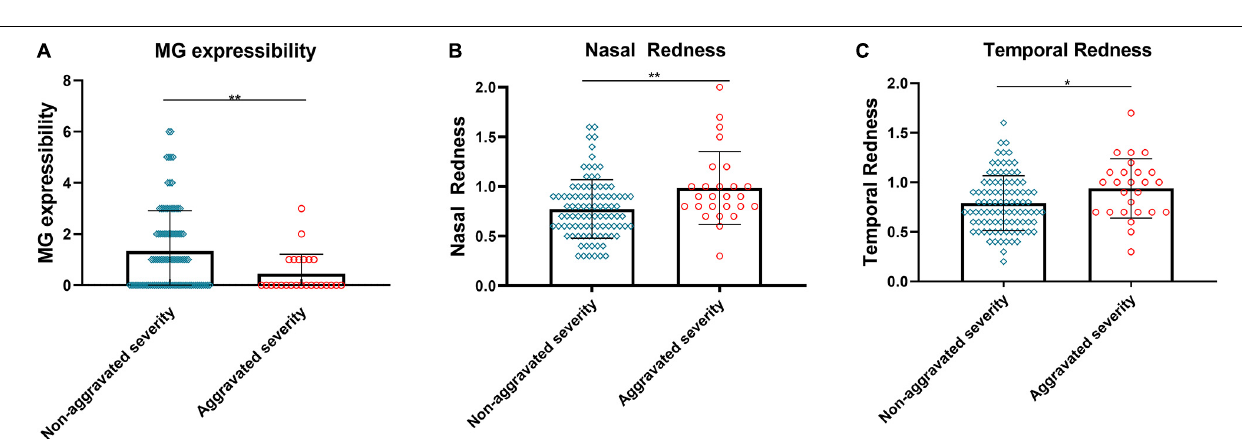
bulbar conjunctival redness after the reading test ( Figure 5A , p ≤ 0.0001). The proportion of nasal bulbar redness index (BRI) > 1 grade was increased from 15.83% at baseline to 38.33% after the reading test ( Figure 5C ). At the same time, the temporal bulbar conjunctival redness ( Figure 5B , p ≤ 0.0001) and the proportion of temporal BRI > 1 grade ( Figure 5D , 21.67% vs.